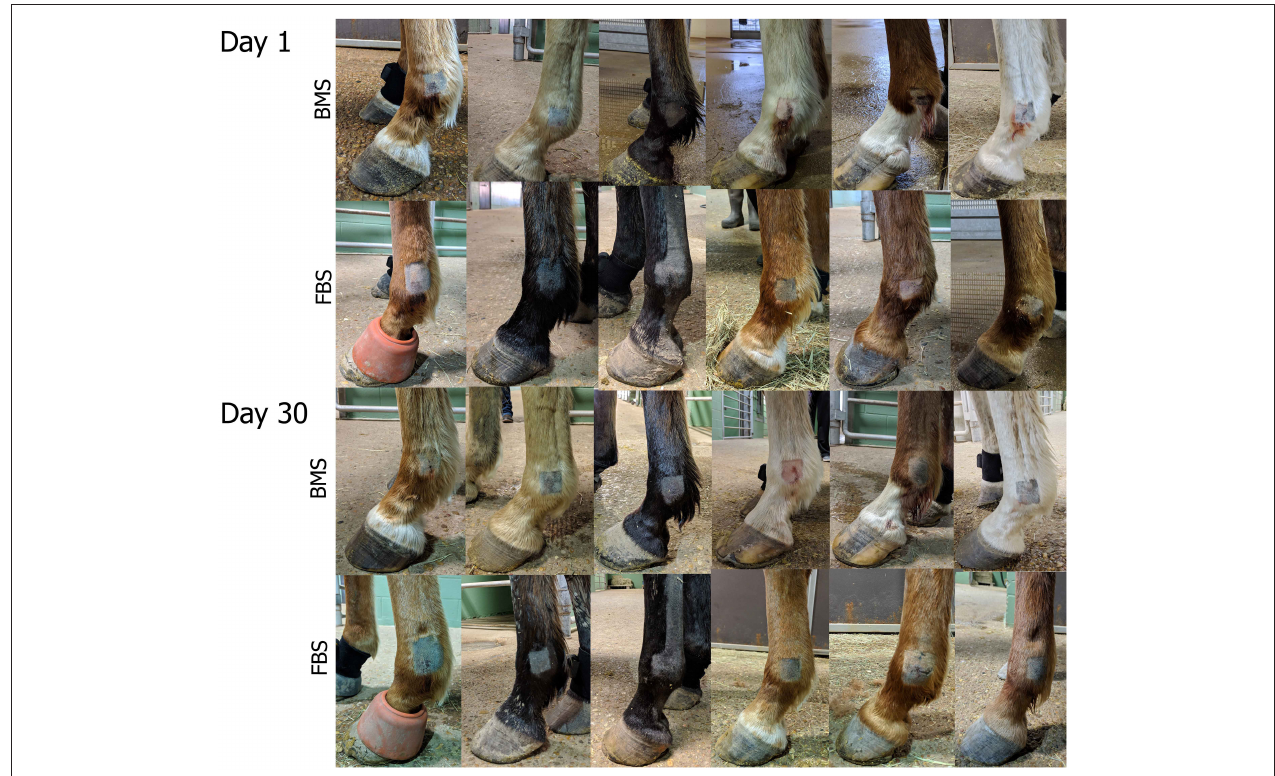
FIGURE 3 | Post-injection edema was marked in FBS-MSC recipients compared to BMS-MSC recipients. Photographs taken on days 1 and 30, one day after FBS-MSC or BMS-MSC injection. There was worse swelling that retained impression (i.e., pitting edema) in FBS-MSC